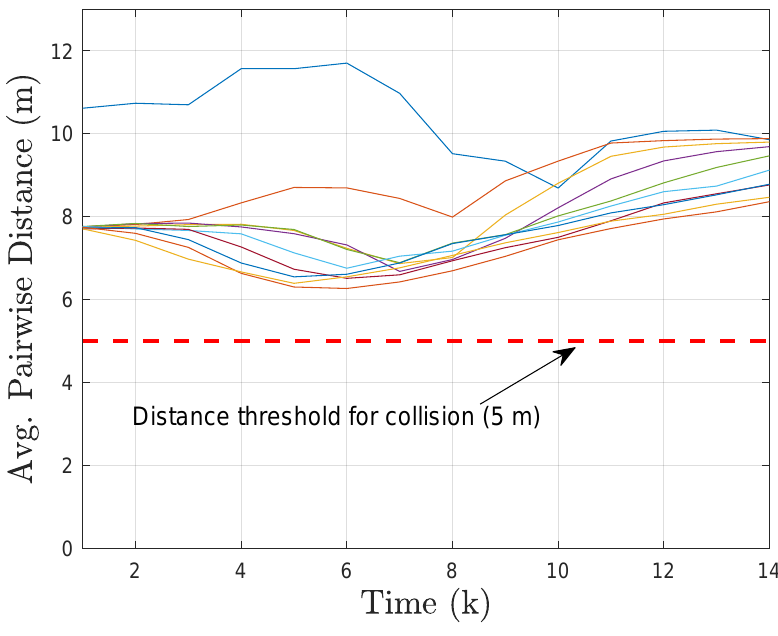
Figure 4. Distance between each pair of UAVs.